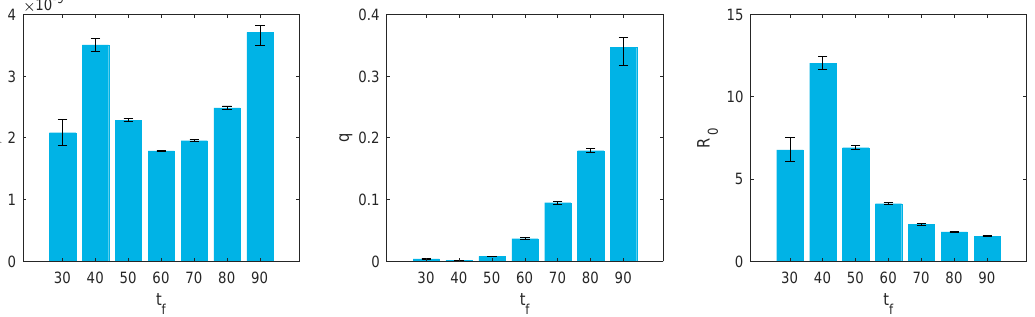
Figure 4. Evolution of transmission rate, isolation rate, and basic reproduction number. The error bars show corresponding 95% confidence